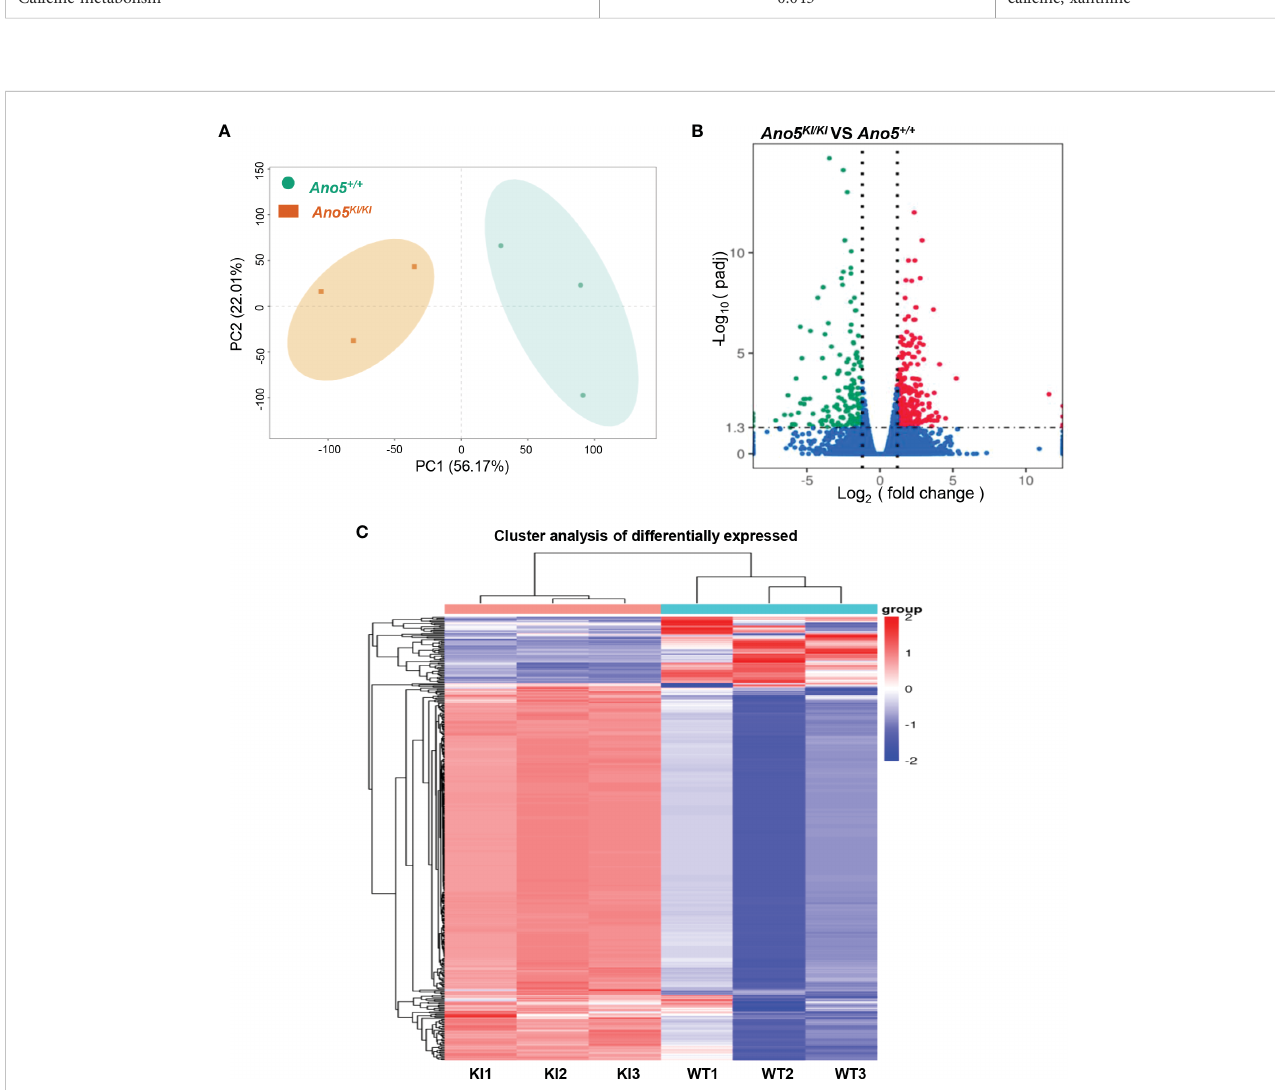
FIGURE 3 Differential gene expression analysis of Ano5 KI/KI (KI) and Ano5 +/+ (WT) groups. (A) PCA of DEGs pro fi les. PC1 and PC2 indicate the degree of interpretation of the principal component analysis model, with the fi rst and second ranked principal components, respectively; (B) Volcano plots of mRNA expression levels. The volcano map is drawn with − log 10 ( p adj ) as the vertical axis and log 2 (fold change) as the horizontal axis. The red dots mean up-regulated mRNAs and the blue dots represent down-regulated mRNAs, and the mRNAs with no signi fi cant changes were shown in grey dots; (C) Hierarchical heatmap of DEG pro fi les. Each row represents a sample, and each column represents an mRNA transcript. The color scale (from bright blue to bright red) indicates increasing transcript